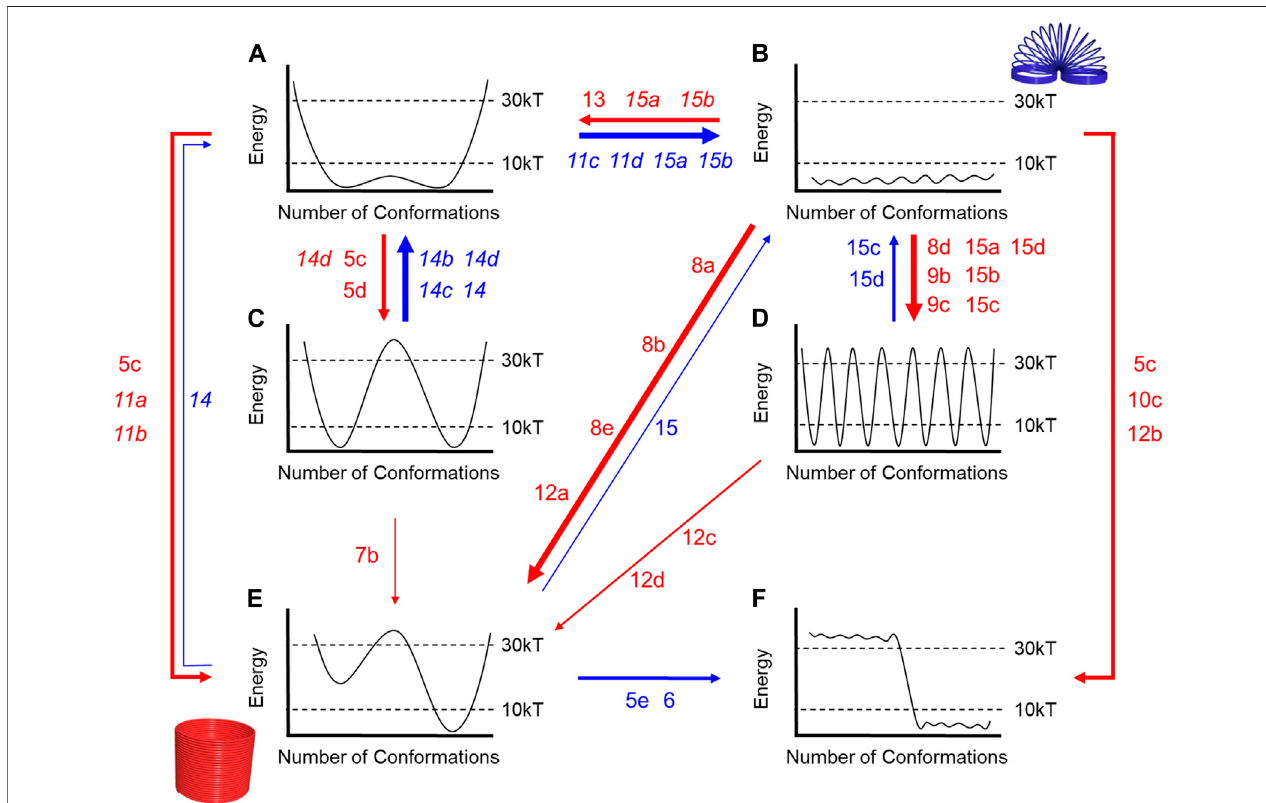
FIGURE 16 | Flowchart annotated with Figure numbers that correspond to examples where the rotaxane either gets more rigid (red arrows) or more fl exible (blue arrows) relative to its components. Thicker arrows represent more examples. Italics are used to indicate examples where two different rotaxane structures are being compared. Letters a-f correspond to the fl ow chart in Figure 4